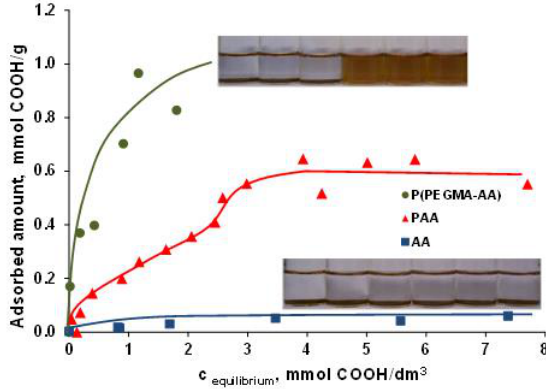
Figure 2. The adsorption isotherm of P(PEGMA-AA) in comparison to AA, PAA [37] isotherms on magnetite surface at pH ~ 6.5 and 10 mM NaCl. The equilibrium concentration and adsorbed amount are related to the molar amount of carboxylic groups (COOH). The error bars are omitted for clarity, and lines are drawn to guide the eyes. The pictures of the adsorption series are taken at increasing equilibrium concentrations of P(PEGMA-AA), from 0 to 2.06 mmol/dm 3 , and of AA from 0 to 7.4 mmol/dm 3 .